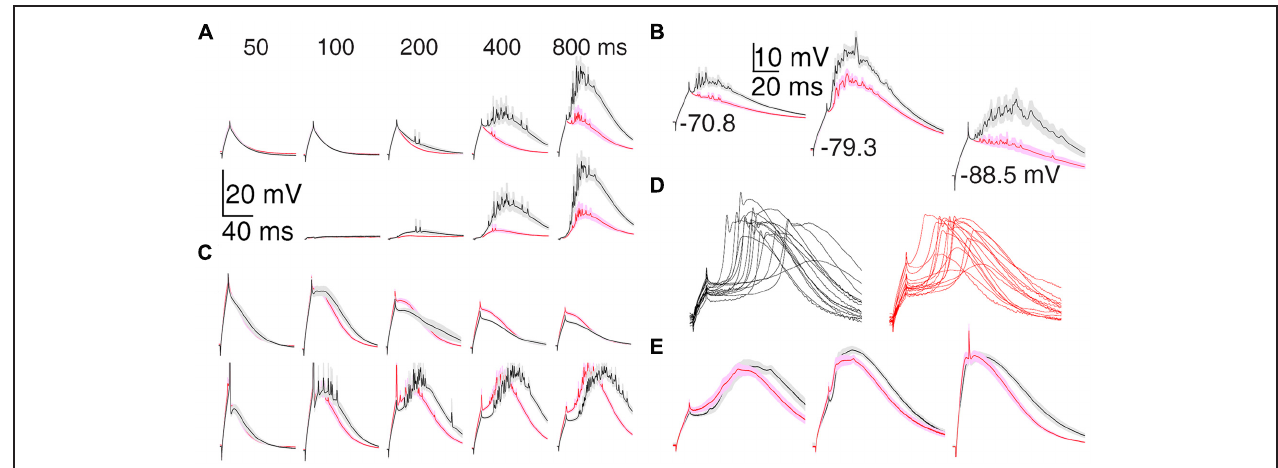
FIGURE 3 | Population average T-type depolarization is larger in motor than visual thalamus. (A) TtD (mean ± SEM) in VL (black) and LGN (red) in the DCSW protocol. The current was selected in each cell that caused an initial depolarization (at current offset) nearest to 11.3 mV (the smallest depolarization present in all cells; range: 9.6–11.9 mV) when injected after 50 ms near − 80 mV. Raw voltage responses are shown at top and isolated TtD at bottom (found by subtracting responses at 50 ms in each cell prior to averaging). Fewer cells were tested at 100 ms ( Table 2 ). (B) Analogous to (A) but for the CCSW protocol. Initial depolarizations were selected to be nearly the same across all neurons but differed across the three baseline voltages. (C) Population average responses just below (top) and above threshold (bottom) for generation of sodium spikes. Neurons were discarded if no spikes were evoked by any current, and thus more neurons were discarded at earlier times. Similar differences between VL and LGN were apparent when analysis was restricted to neurons tested up to 1000 pA (which caused a spike in all neurons at all times). (D) The fLTS evoked from near − 80 mV in the presence of TTX (0.5–2.0 µ M) in all 30 neurons in which it was administered, including eight and seven neurons in DCSW (800 ms) and CCSW protocols, respectively, in both VL (left) and LGN (right). (E) For the neurons in (D) the population fLTS (mean ± SEM; left), the LTS in response to 100 pA more than required to evoke the fLTS (middle), and the LTS in response to our maximum tested current of 1000 pA (right; 1000 pA was tested in only 14 neurons, seven in VL and LGN, in the DCSW protocol). The fLTS was evoked by currents of 180–660 pA across all neurons. The timing of the LTS was less variable in response to larger currents, and this allows the sharp initial peak to appear in the population average with 1000 pA (right) but not smaller currents (left and